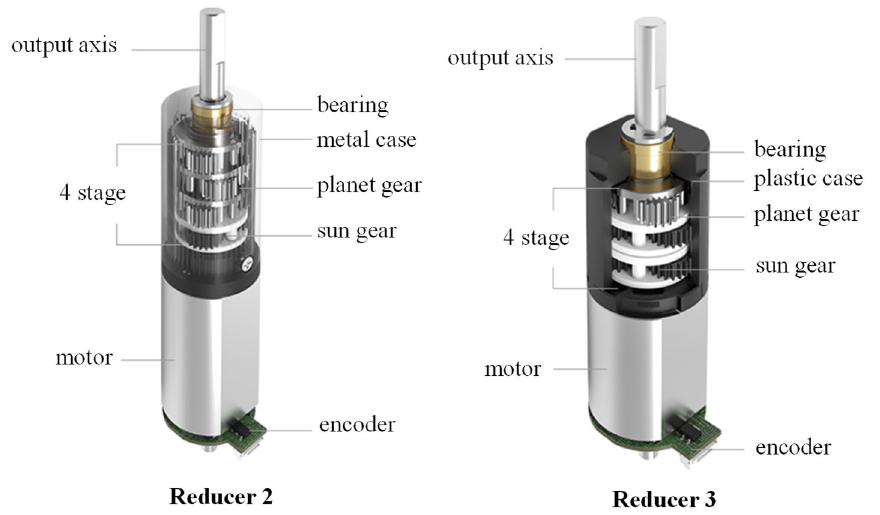
Figure 9. Composition of reducer 2 and 3.